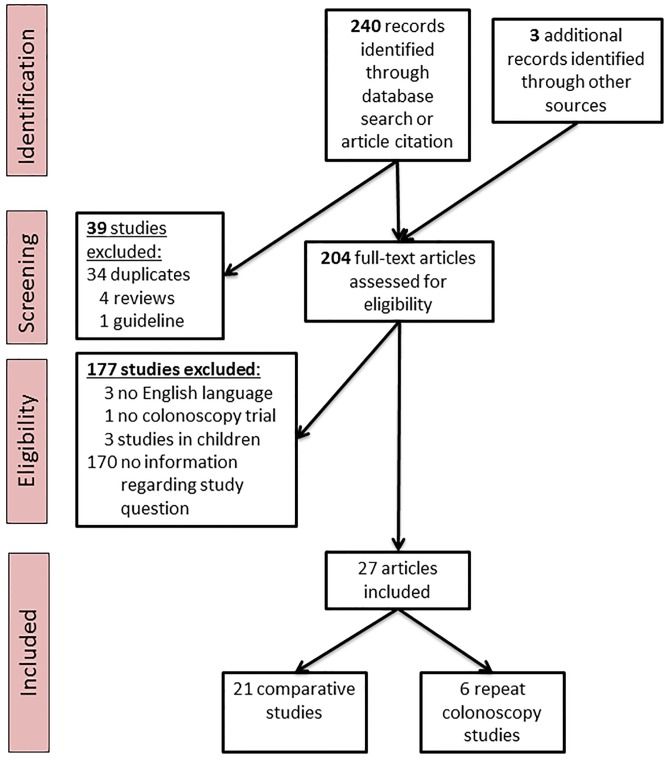
PRISMA flow diagram.